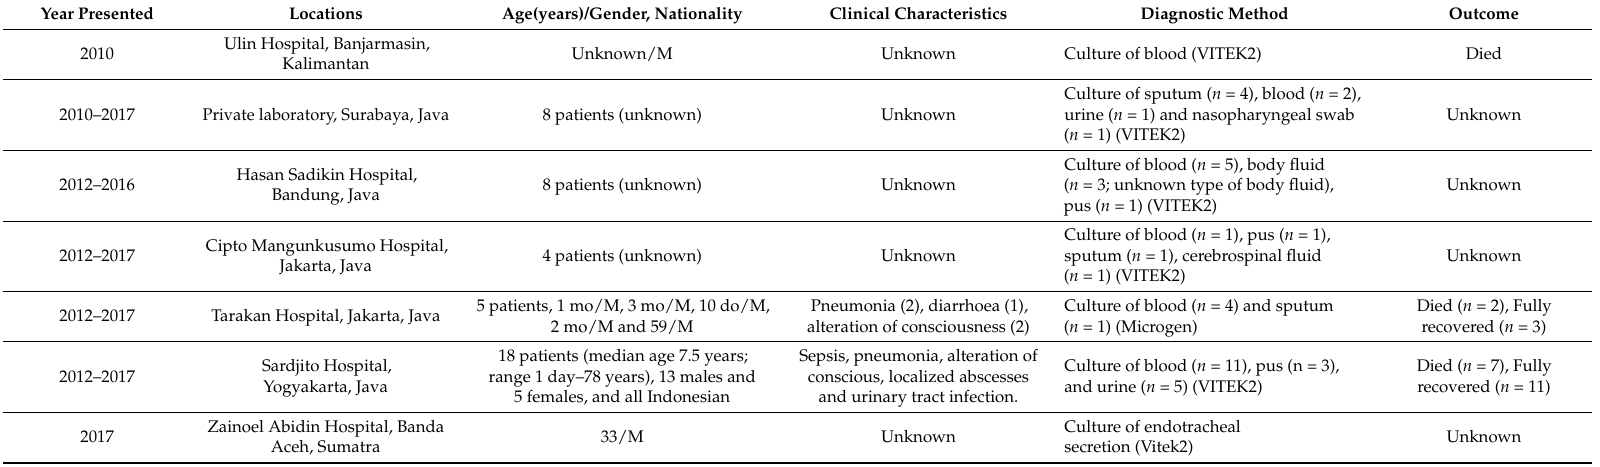
Table 2. Newly reported indigenous melioidosis human cases in Indonesia ( n = 45 cases).